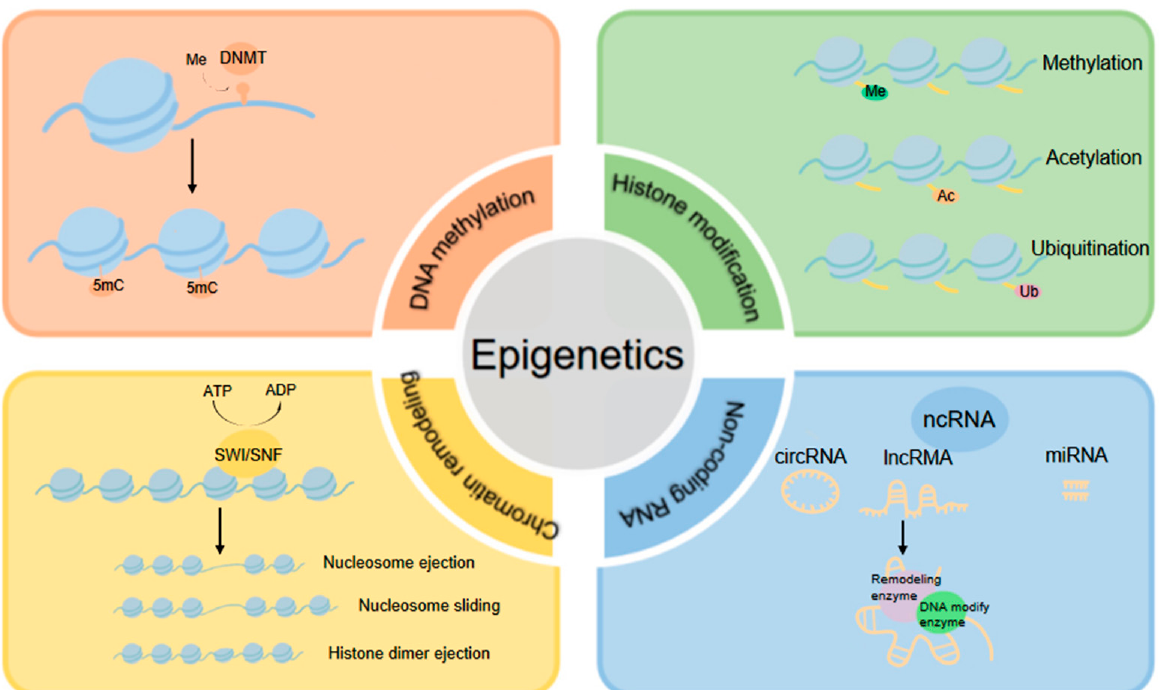
Figure 2. Epigenetic changes include DNA methylation, histone modification, chromatin remodeling, and changes to noncoding RNA profiles. DNA methylation involves the transfer a methyl group to the C5 position of cytosine in CpG dinucleotides to form 5-methylcytosine (5mC). Histone core protein possesses a characteristic tail that is enriched for lysine and arginine residues, which are subject to post-translational modifications. Acetylation, methylation, ribosylation, or phosphorylation of histone proteins can influence gene expression. The ncRNAs include circular RNA (circRNA), long non-coding RNA (lncRNA), and microRNA (miRNA). Some specific lncRNAs are associated with chromatin remodeling and modification complexes. Chromatin remodeling involves the ATP-dependent SWItch/sucrose non-fermentable (SWI/SNF) complex that functions in the mobilization, ejection, and exchange of histones.